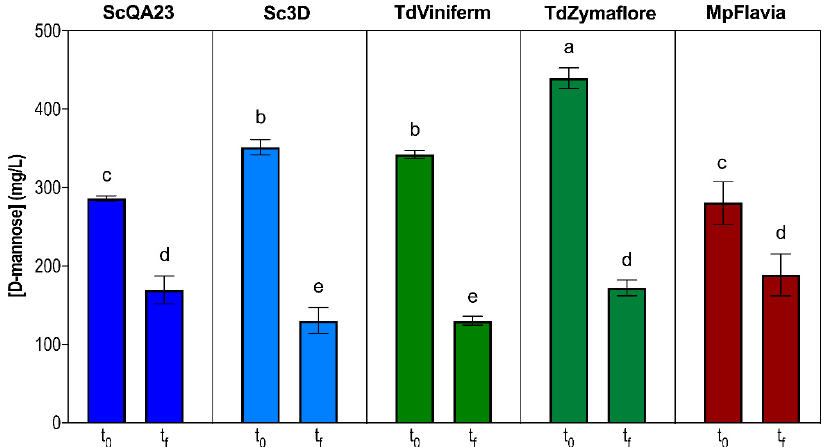
Figure 2. Mannoprotein concentration (mg of mannose eq./L) before and after malolactic fermentation in natural grape wines produced following different yeast inoculation strategies. Sc, Td, and Mp represent S. cerevisiae , T. delbrueckii, and M. pulcherrima, respectively, followed by the name of the commercial strain. t 0 and t f represent before O. oeni inoculation and at the end of MLF ((L-malic acid) < 0.1 g/L). a–e Significantly different at p ≤ 0.05 according to a Tukey post-hoc comparison test.